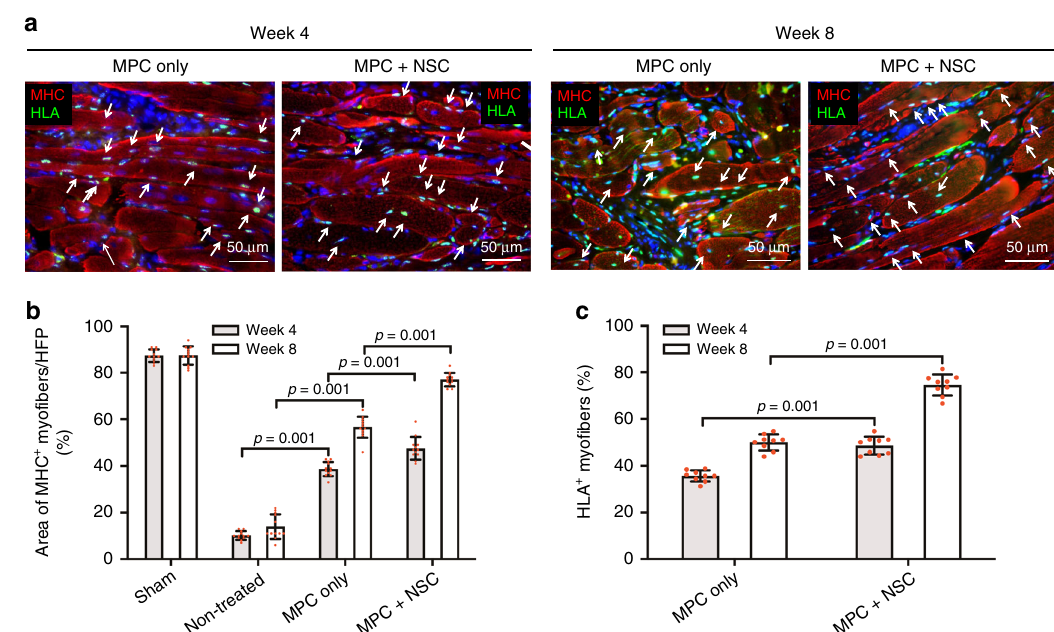
Fig. 6 Myo fi ber formation and maturation. a Immuno fl uorescence for MHC (red)/human leukocyte antigen (HLA, green) of injured TA muscles at 4 and 8 weeks after implantation. The presence of MHC + HLA + cells in the implanted region indicates that implanted human MPCs survived and contributed to newly formed muscle fi bers (white arrow). b Quanti fi cation of the area of MHC + myo fi bers per fi eld (%, ×400) ( n = 3 per group and time point, four random fi elds per sample). c Quanti fi cation of HLA + myo fi bers (%, ×400) ( n = 3 per group and time point, three random fi elds per sample). All data are represented as mean ± SD. The p -values by two-way ANOVA followed by Tukey ’ s test are